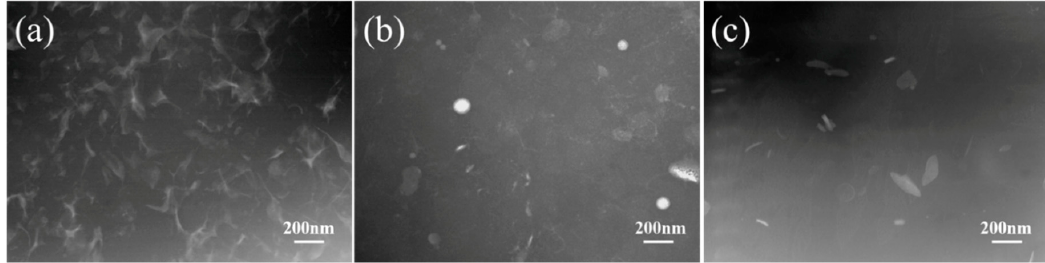
Figure 3. STEM images of NR ( a ), centrifuged NR (CNR)-1 ( b ), and CNR-2 ( c ).